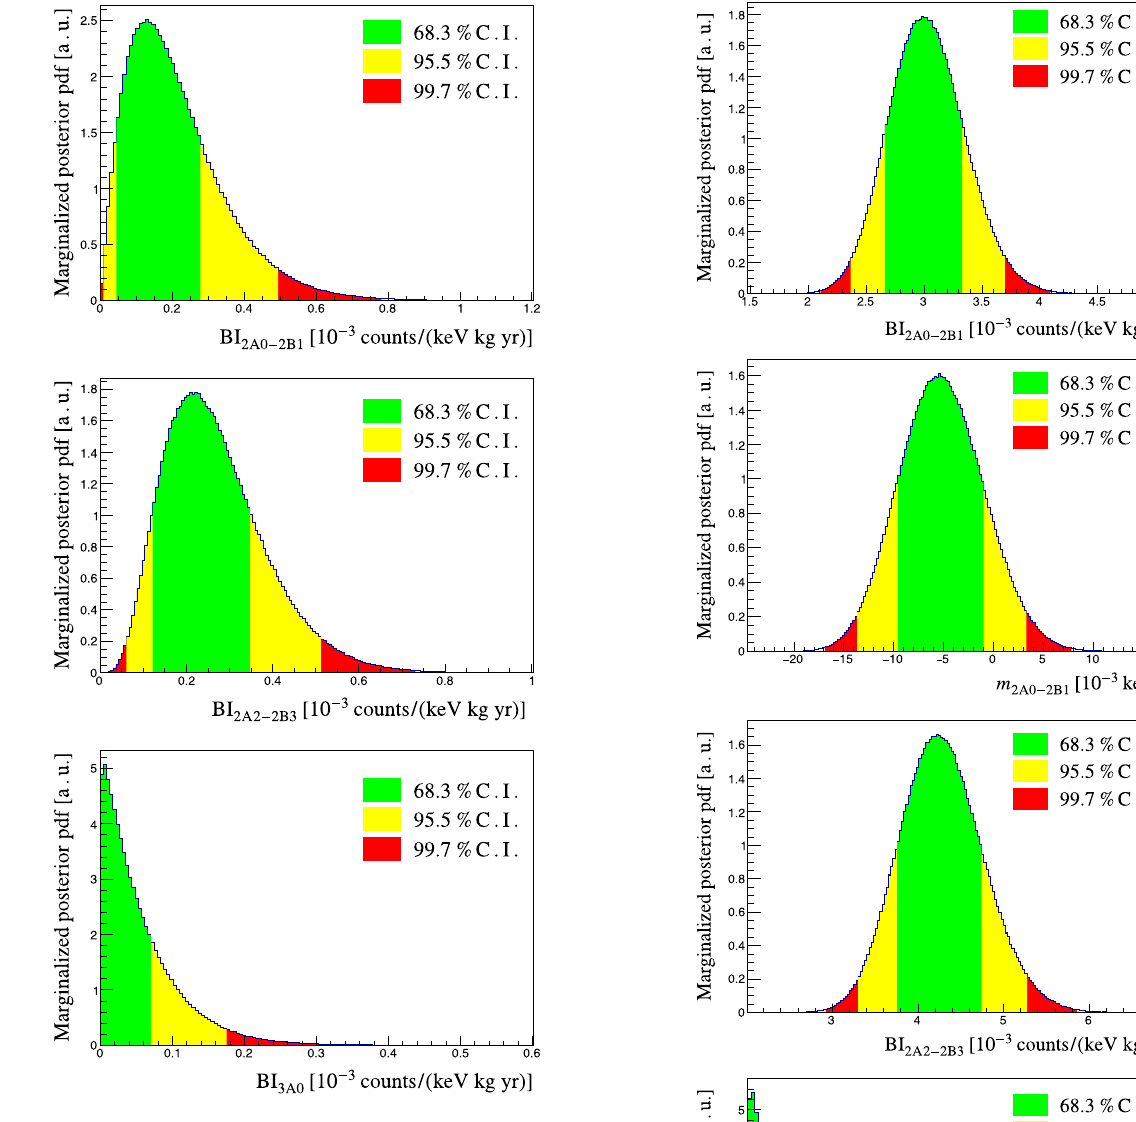
Fig. 5 Marginalized posterior pdf for the background parameters of the 0 νββ model from the combined fit with all systematics. We show the 68 . 3% , 95 . 5% , 99 . 7% smallest C.I. in green, yellow and red respec- tively